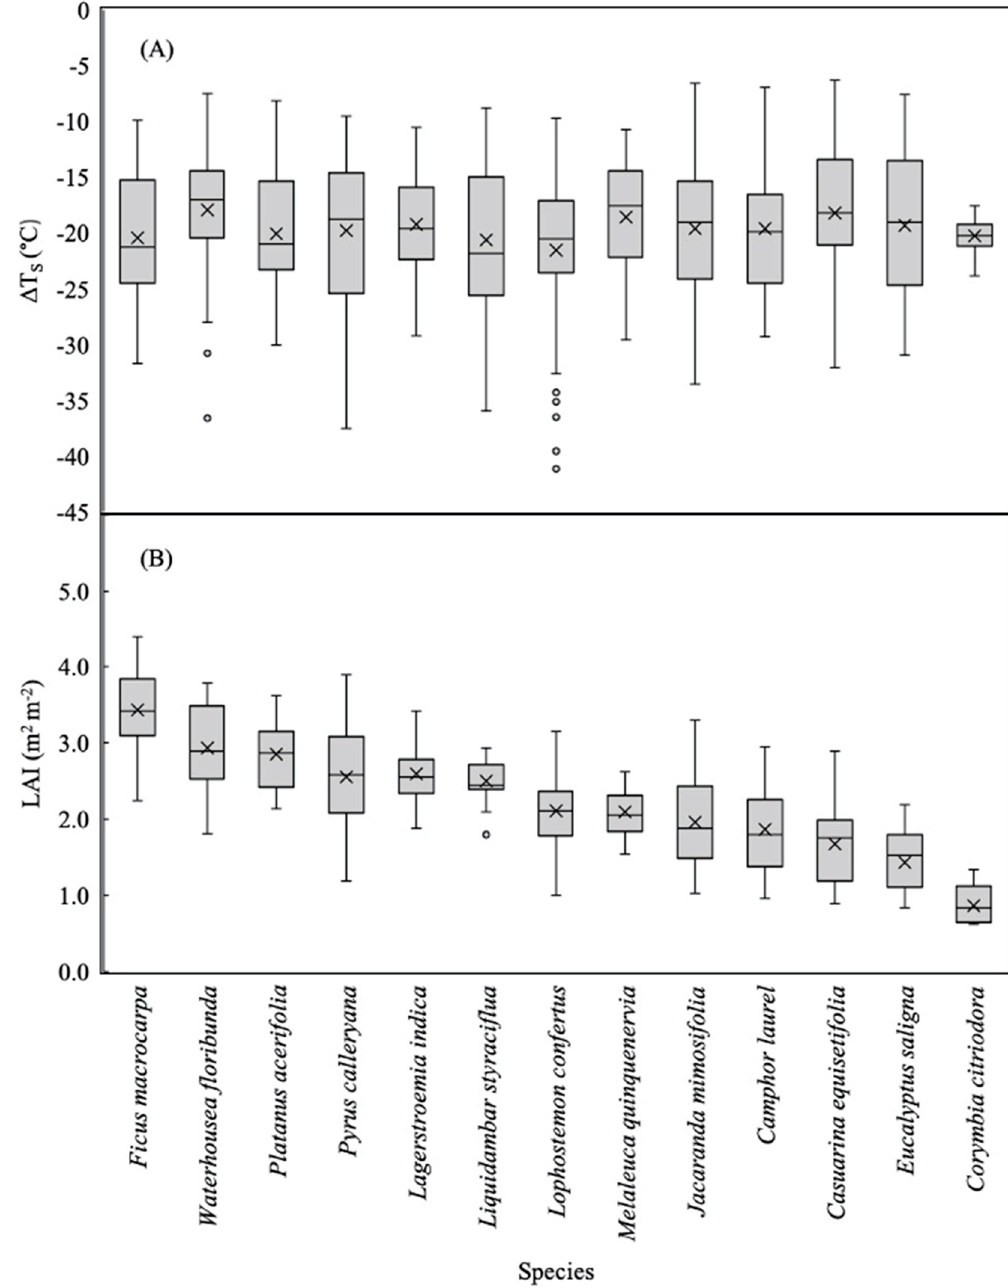
Figure 4. Distribution of the surface temperature differential ( Δ T S ; panel ( A )) and Leaf Area Index (LAI; panel ( B )) in each tree species. Distribution of LAI in each species is arranged from the highest mean LAI to the lowest mean LAI. The lower and upper line of the box shows the first and third quartile; the line and cross inside the box show the median and mean; the whiskers show minimum and maximum values.